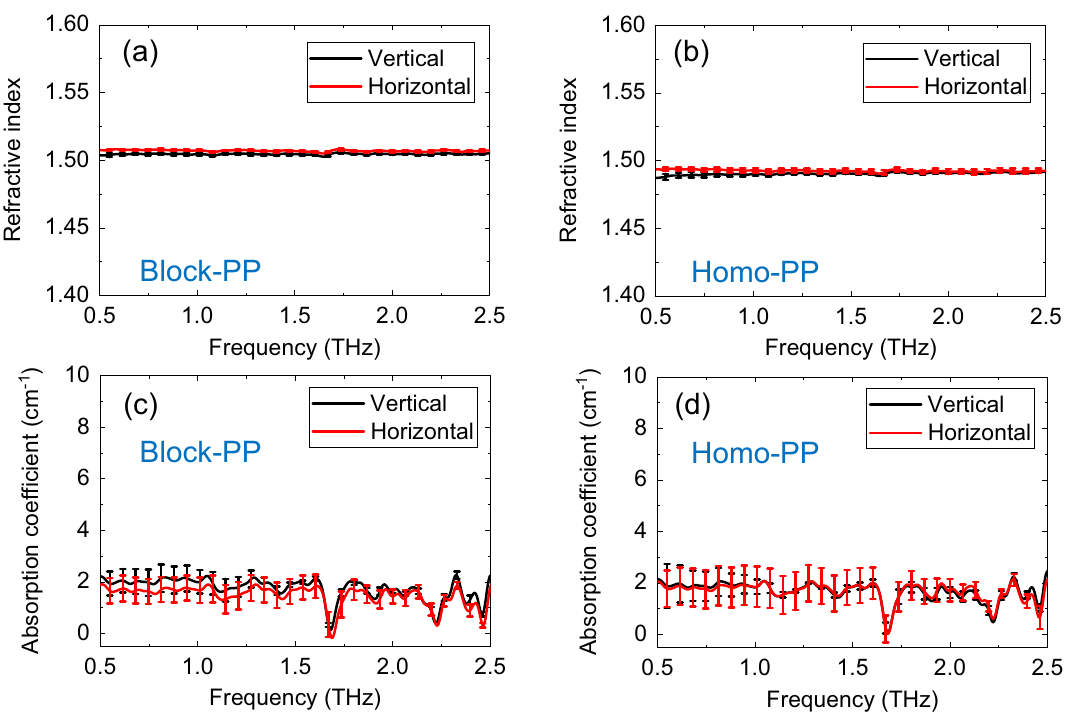
Figure 3. ( a ) Refractive index of block-PP, ( b ) refractive index of homo-PP, ( c ) absorption coefficient of block-PP, ( d ) absorption coefficient of